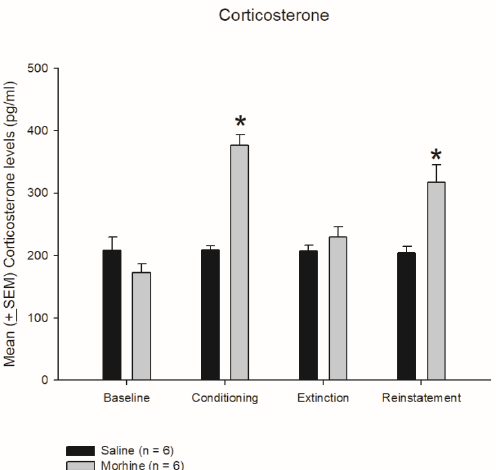
Figure 5. Mean (±SEM) plasma corticosterone levels (pg/mL) in the saline and morphine groups ( n = 6 per group) at baseline and in the conditioning, extinction, and reinstatement phases. * p < 0.05 when comparing the saline and morphine groups ( n = 6 per group). when comparing the saline and morphine groups ( n = 6 per